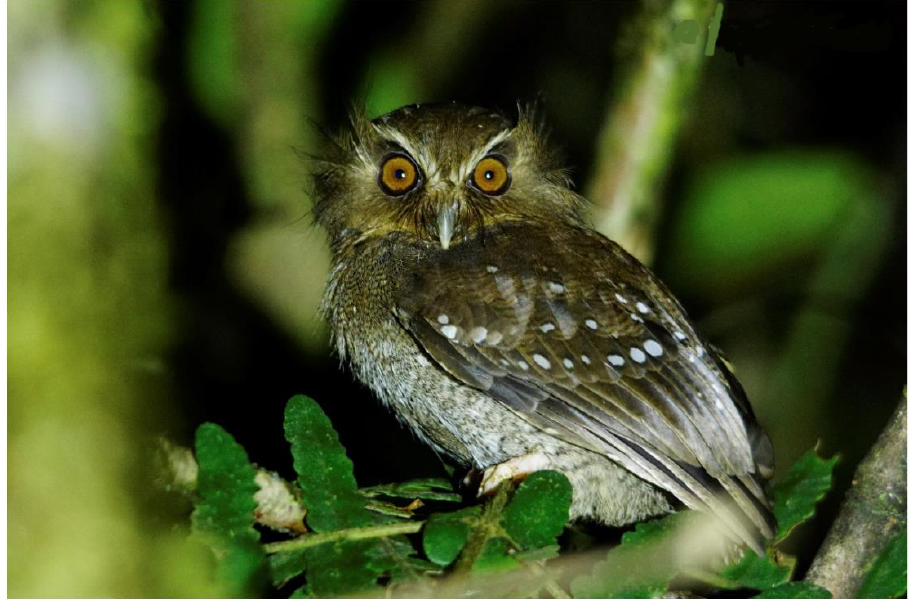
Figure 2. X. loweryi ’s natural habitat in montane forests of Fundo Alto Nieva—San Martin. Photo taken by Kenny Neill Rodriguez Añazco .